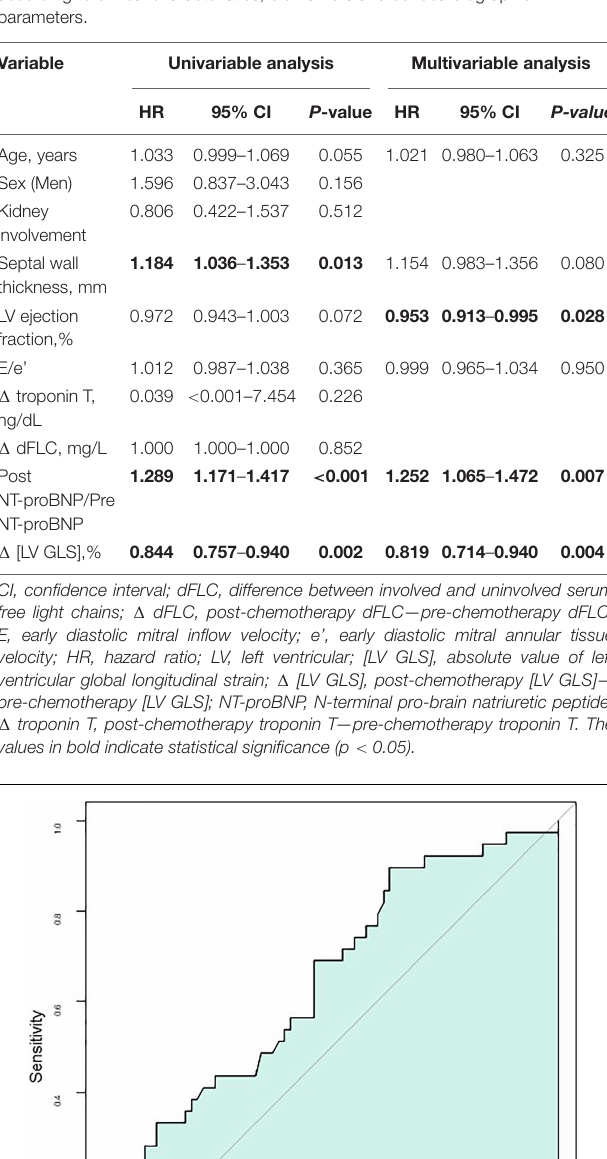
deviation (SD) or median (interquartile range),